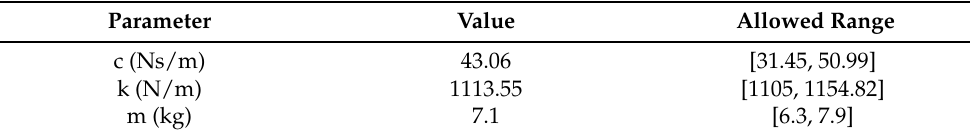
Table 2. Assumed values of the parameters and acceptable range of